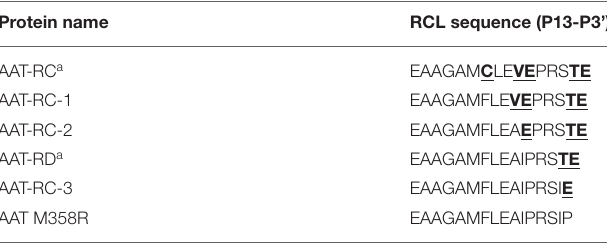
TABLE 1 | RCL sequences of AAT M358R and variants examined or considered in this study. Protein